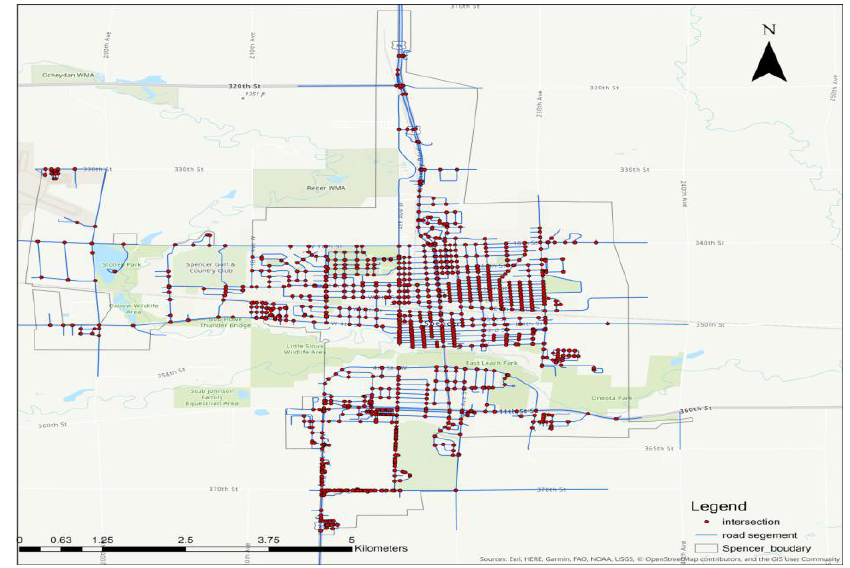
Figure 7. Distribution of intersections in Spencer city.